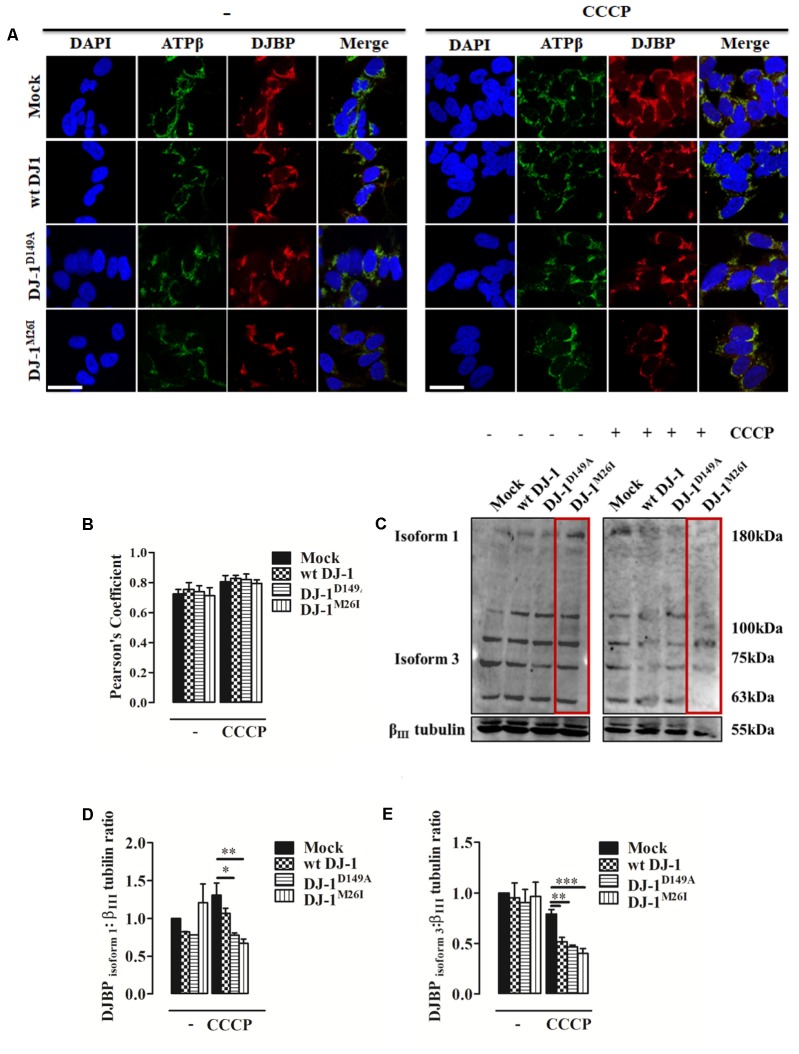
During mitophagy DJBP is recruited to mitochondria. (A) Representative immunofluorescence of double staining of DJBP (red) and ATPβ (green) fluorescence in SH-SY5Y cells transfected with FLAG-DJ-1 (wt DJ-1) or mutant FLAG-DJ-1 constructs before and after induction of mitophagy via CCCP (8 h, 10 μM). Scale bar = 10 μm. (B) The bar graph shows the quantitative analysis of co-expression levels by Pearson’s coefficient [untreated Mock: 0.72 ± 0.03, wt DJ-1: 0.76 ± 0.04, DJ-1D149A: 0.74 ± 0.04, DJ-1M26I: 0.71 ± 0.05; 8 h CCCP 10 μM Mock: 0.80 ± 0.04, wt DJ-1: 0.83 ± 0.02, DJ-1D149A: 0.82 ± 0.04, DJ-1M26I: 0.79 ± 0.02; data are shown as mean ± SEM (n = 3; no variance was observed)]. Panel (C) shows Western blot analysis of DJBP in total extracts during mitophagy, which reveals protein isoforms, analyzed and quantified in (D,E) using anti-DJBP and anti-βIII tubulin (loading control) antibodies [DJBPisoform1 density, untreated Mock: 1 ± 0.00, wt DJ-1: 0.82 ± 0.002, DJ-1D149A: 0.78 ± 0.001, DJ-1M26I: 1.21 ± 0.248; 8 h CCCP 10 μM Mock: 1.31 ± 0.16, wt DJ-1: 1.07 ± 0.07, DJ-1D149A: 0.78 ± 0.03, DJ-1M26I: 0.67 ± 0.06; DJBP isoform 3 density, untreated Mock:1 ± 0.00, wt DJ-1:0.95 ± 0.15, DJ-1D149A: 0.90 ± 0.13, DJ-1M26I: 0.96 ± 0.14; 8 h CCCP 10 μM Mock: 0.79 ± 0.04, wt DJ-1: 0.52 ± 0.04, DJ-1D149A: 0.47 ± 0.02, DJ-1M26I: 0.40 ± 0.05; data are shown as mean ± SEM (n = 3; ∗∗∗p < 0.001; ∗∗0.001 < p < 0.01; ∗0.01 < p < 0.05)].